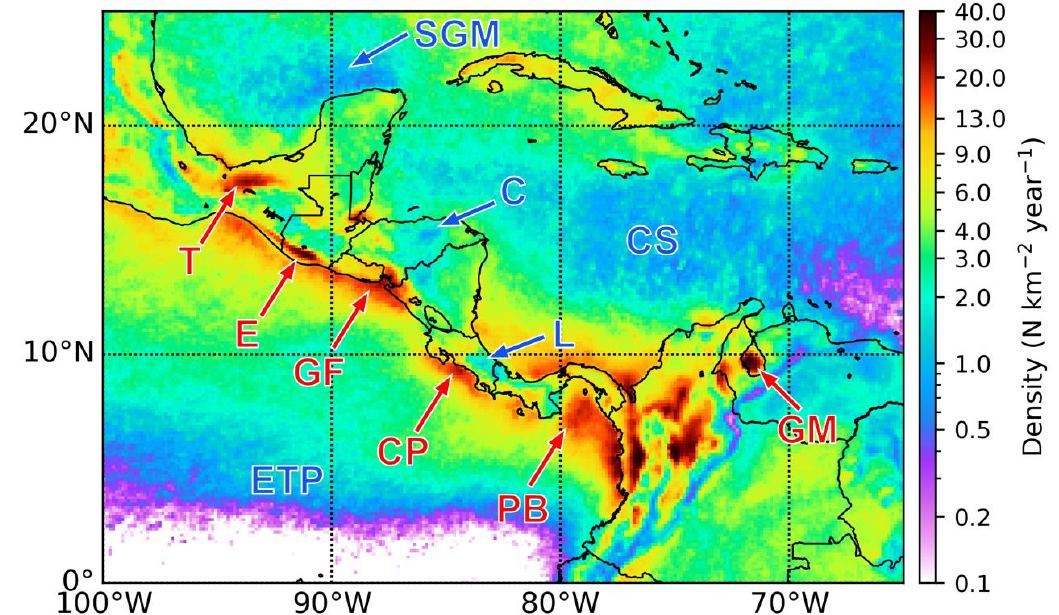
Figure 3. Annual average density of lightning activity (total number N of strokes km −2 month −1 ) over the Extended Central America region 2012-2020. Major lightning hot-spots are in Tehuantepec (T), Escuintla (E), Gulf of Fonseca GF, Central Pacific (CP), Panama Bight (PB), and Gulf of Maracaibo (GM). Major lightning cold-spots are in the southern Gulf of Mexico (SGM), Colón (C), and Limón (L). ETP and CS stand for the eastern tropical Pacific and the Caribbean Sea, respectively. Data from the World Wide Lightning Location Network (WWLLN) for 2012–2020.